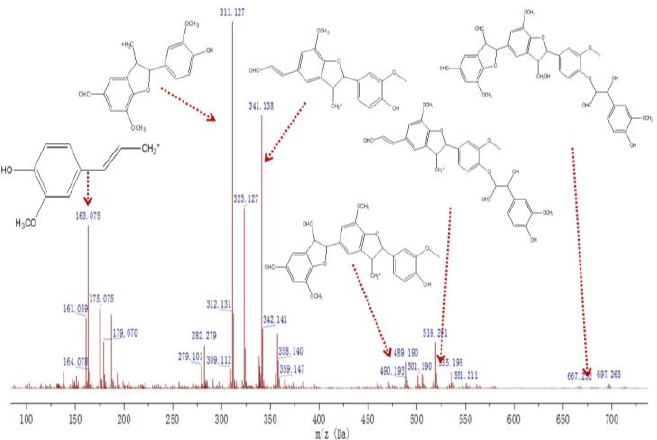
Figure 13. Mass spectrum of the compound G 3 .